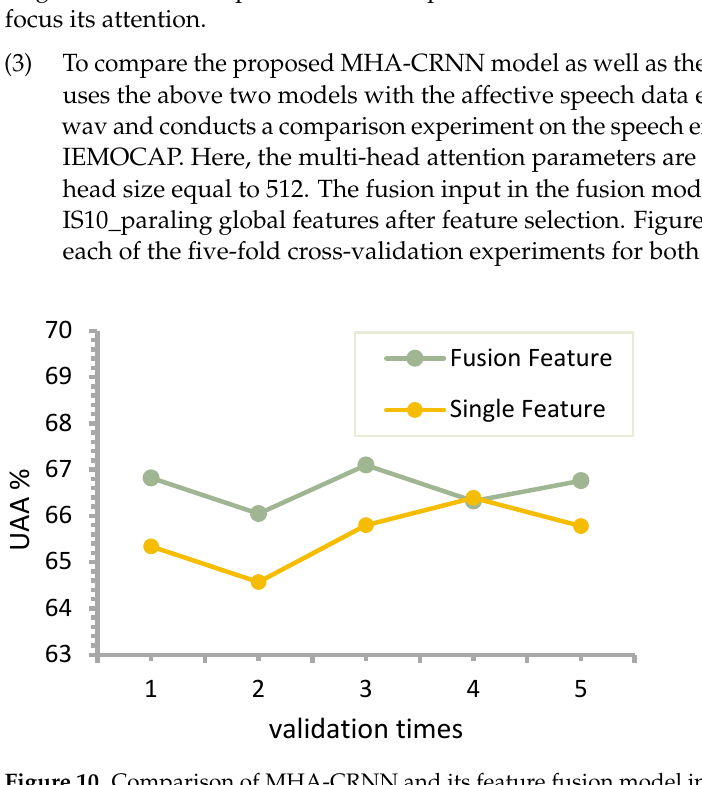
Table 3. The four categories of tasks on the dataset IEMOCAP are compared with other works. Method